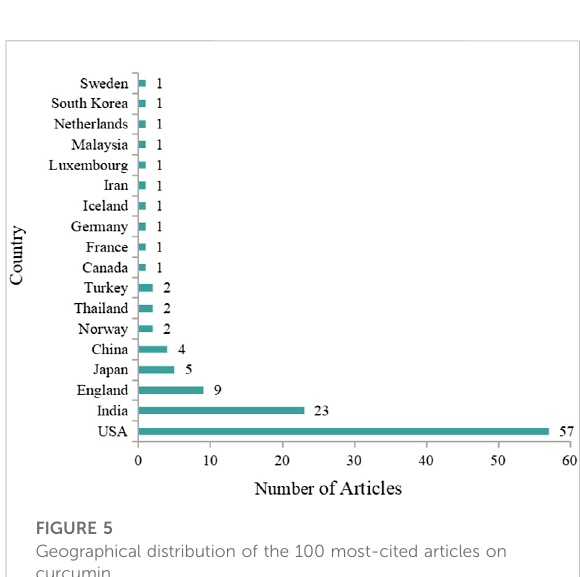
FIGURE 5 Geographical distribution of the 100 most-cited articles on